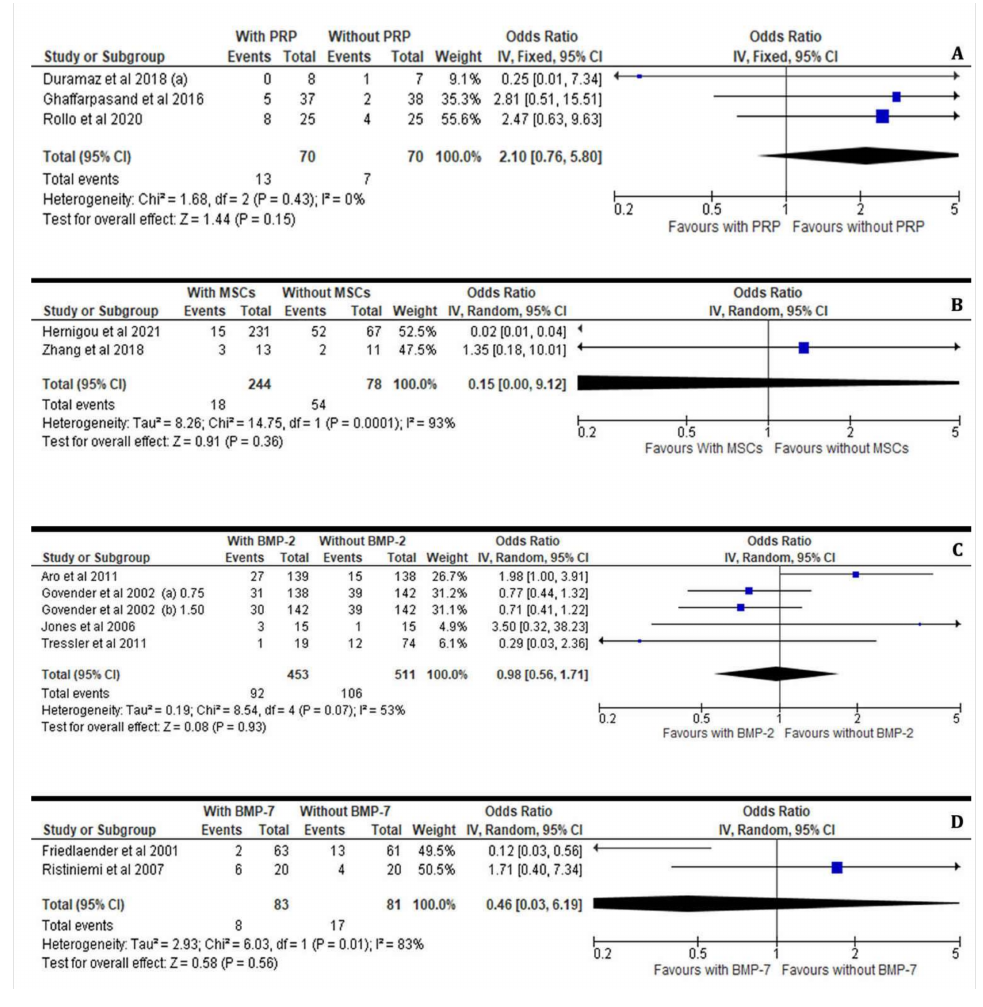
Figure 8. Forest plots showing the incidence of infections after the application of osteoinductive factors PRPs ( A ), MSCs ( B ), BMP-2 ( C ) and BMP-7 ( D ) in the treated versus the non-treated (control) groups